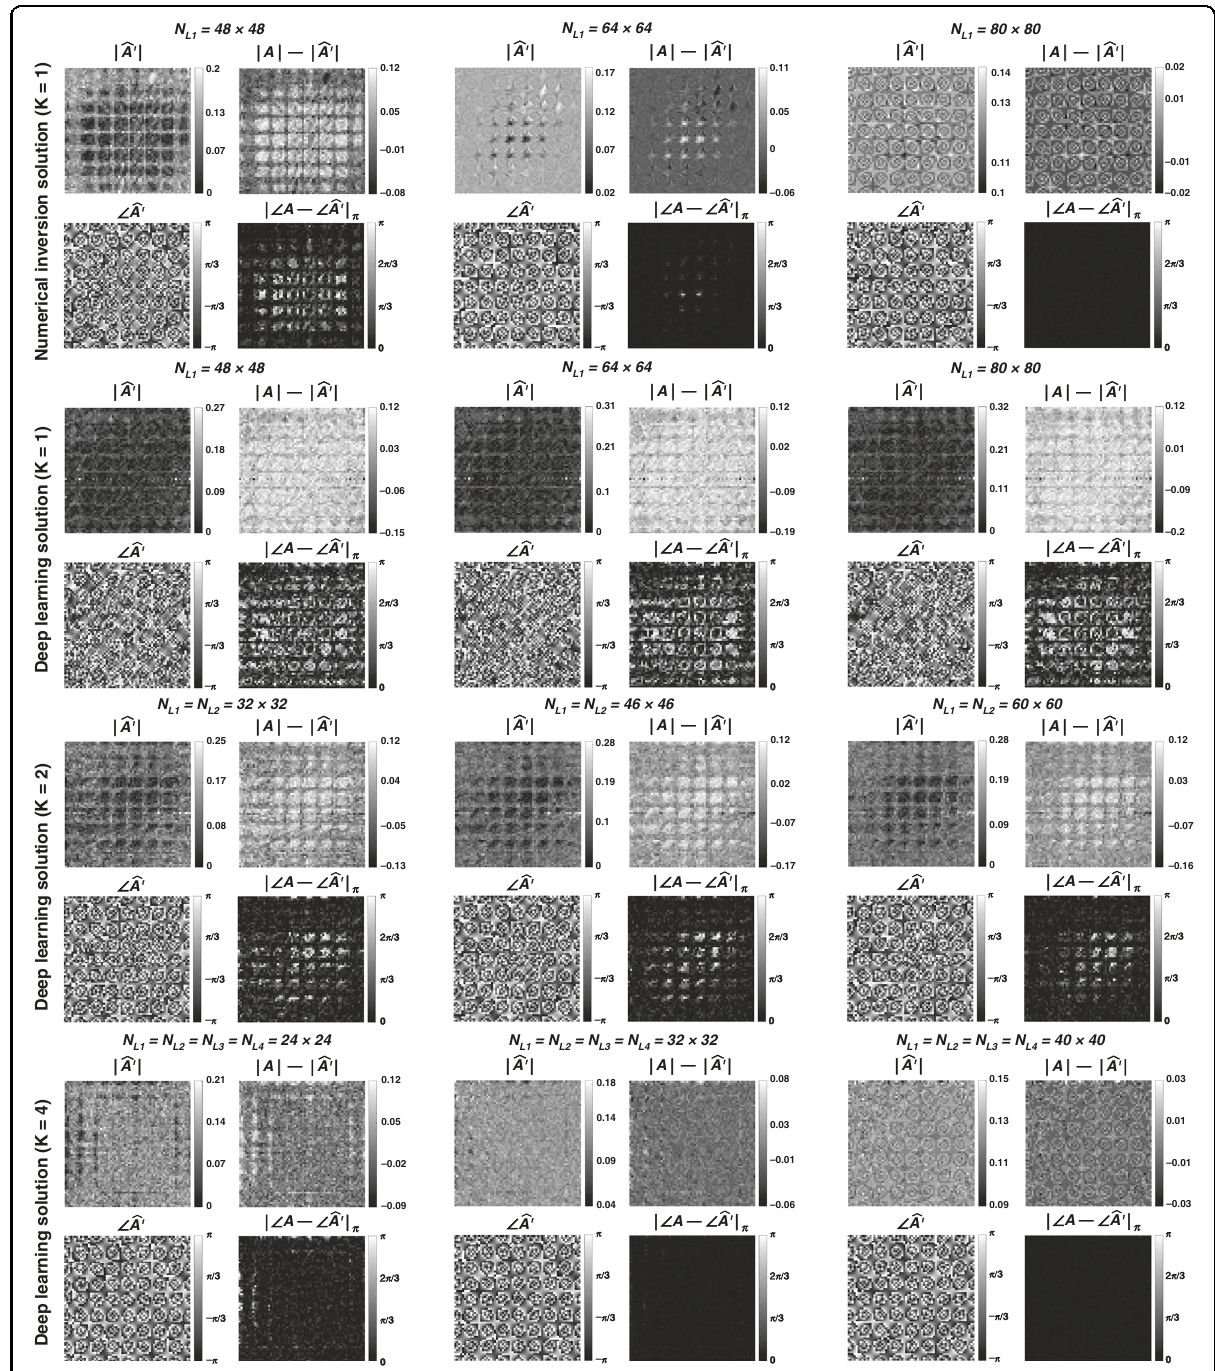
Fig. 8 Diffractive all-optical transformations and their differences from the ground truth, target transformation (A) presented in Fig. 7b. (cid:5) (cid:5) (cid:5) (cid:5) (cid:5) (cid:5) indicates the wrapped phase difference between the ground truth and the normalized all-optical ff A (cid:2) ff b A ′ π